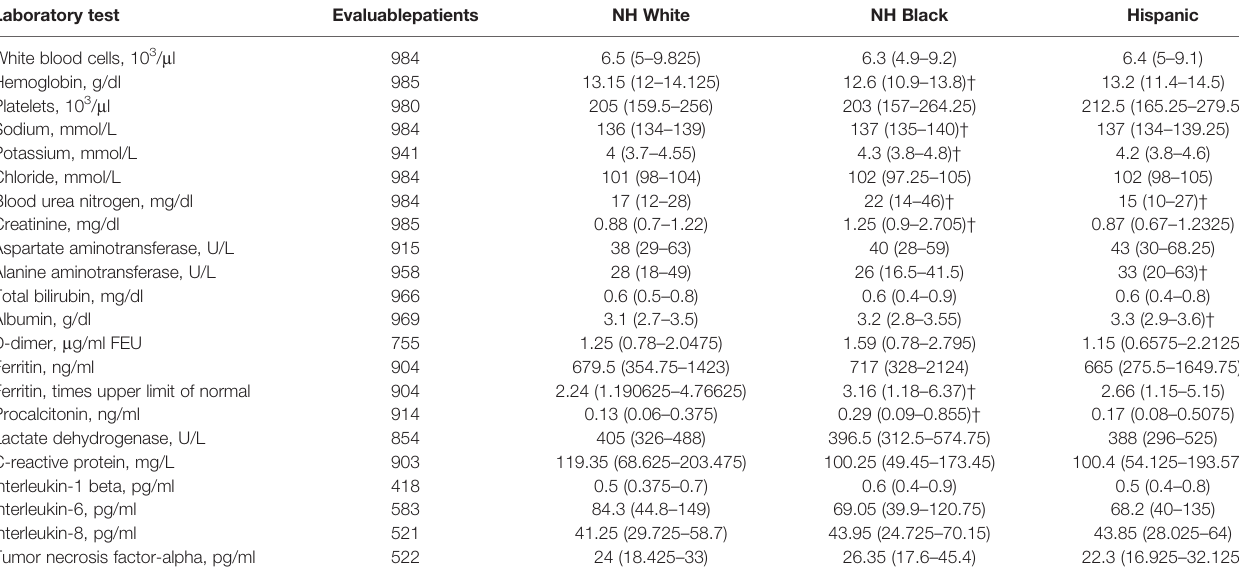
TABLE 3 | Baseline laboratory values among patients admitted to The Mount Sinai Hospital, by